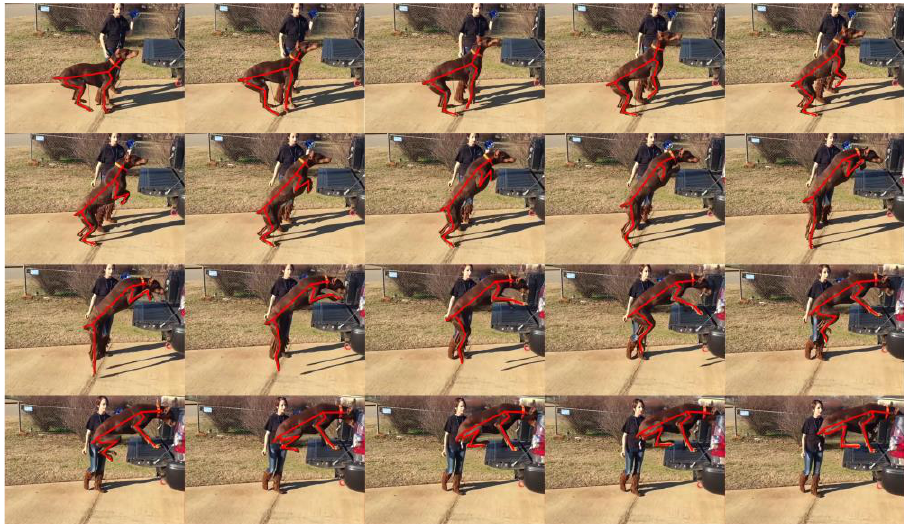
Figure 4. Frame capture of a dog jumping onto a platform to extract the position information of the trunk and legs.